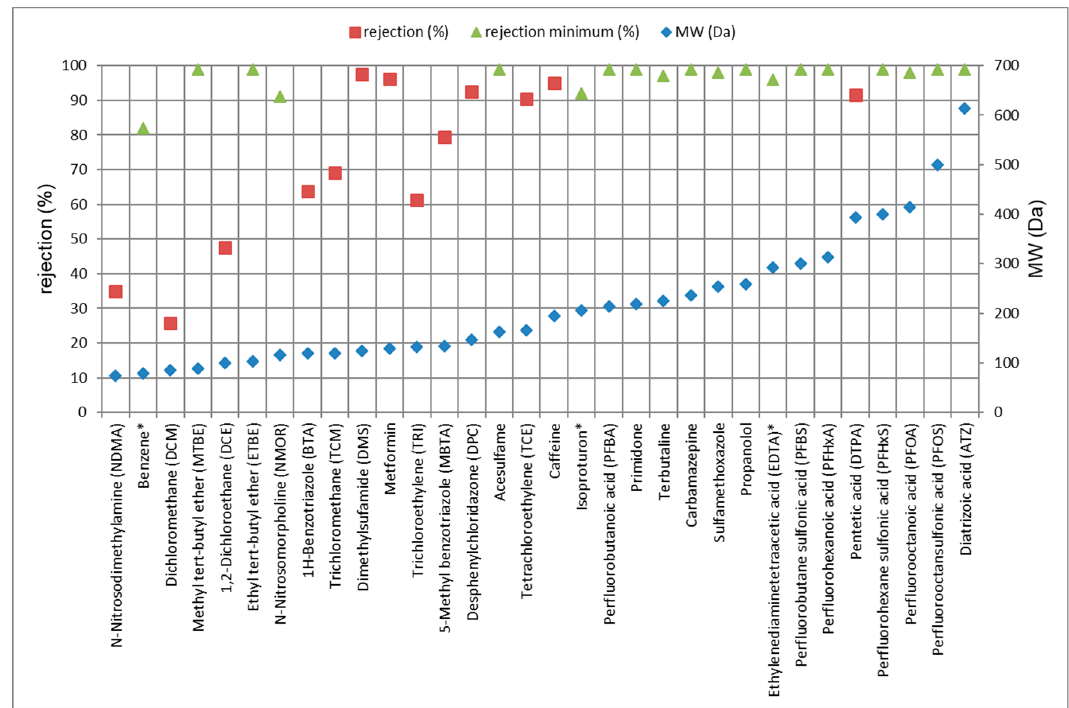
Figure 4. Relationship between molecular weight of TrOCs and rejection values measured at 31 L/m²·h, with the exception of those with sign (*) measured at 25 L/m²·h. The minimum rejection refers to the calculated values using LOQ.